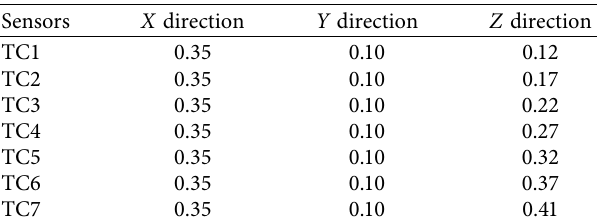
Figure 1: 3D view of the experimental room with the installed sensors. Table 1: Cartesian coordinates of sensors installed in the experi- mental room.